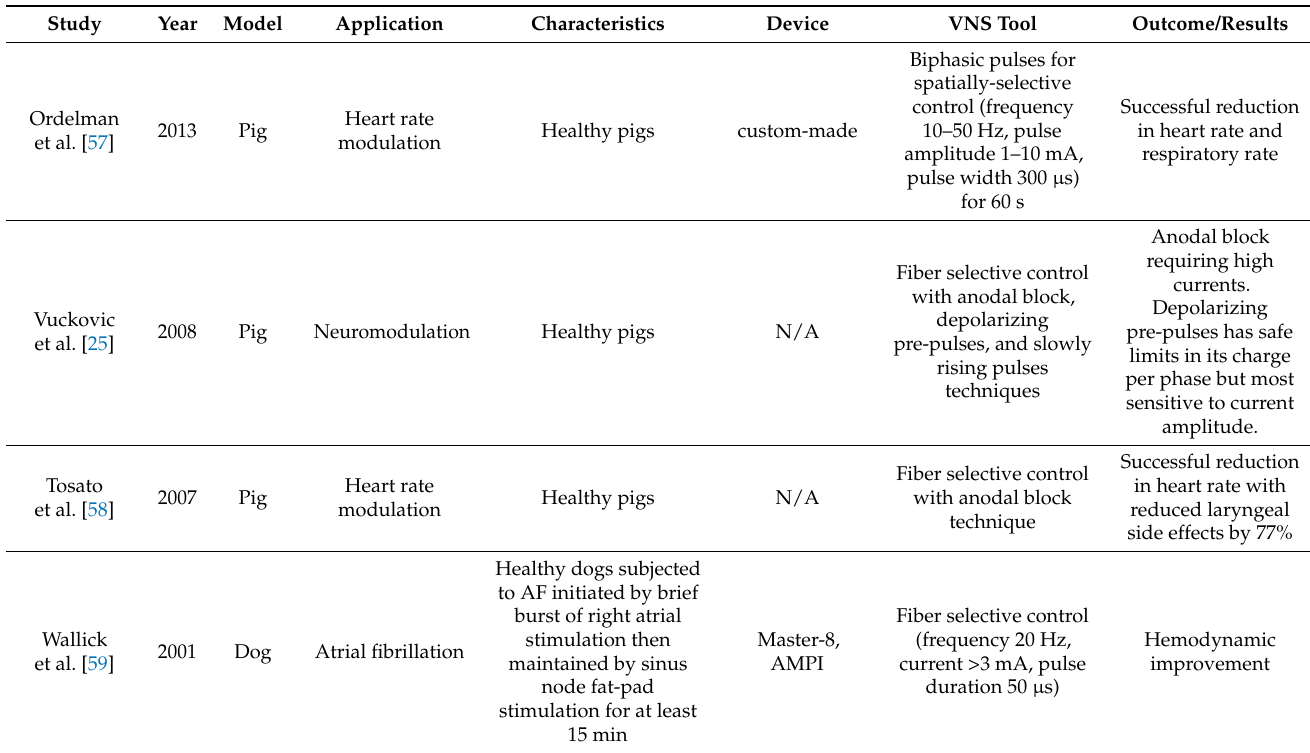
Figure 3. The devices used for achieving VNS were mostly made by Cyberonics Inc. (Figure 4). Most of the studies used custom-made generators for the purpose of their